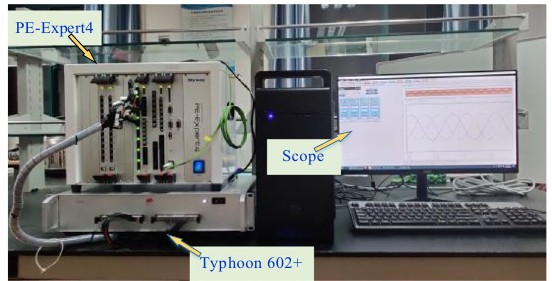
Fig. 6 Typhoon and PE-Expert4 hardware-in-loop experimental platform